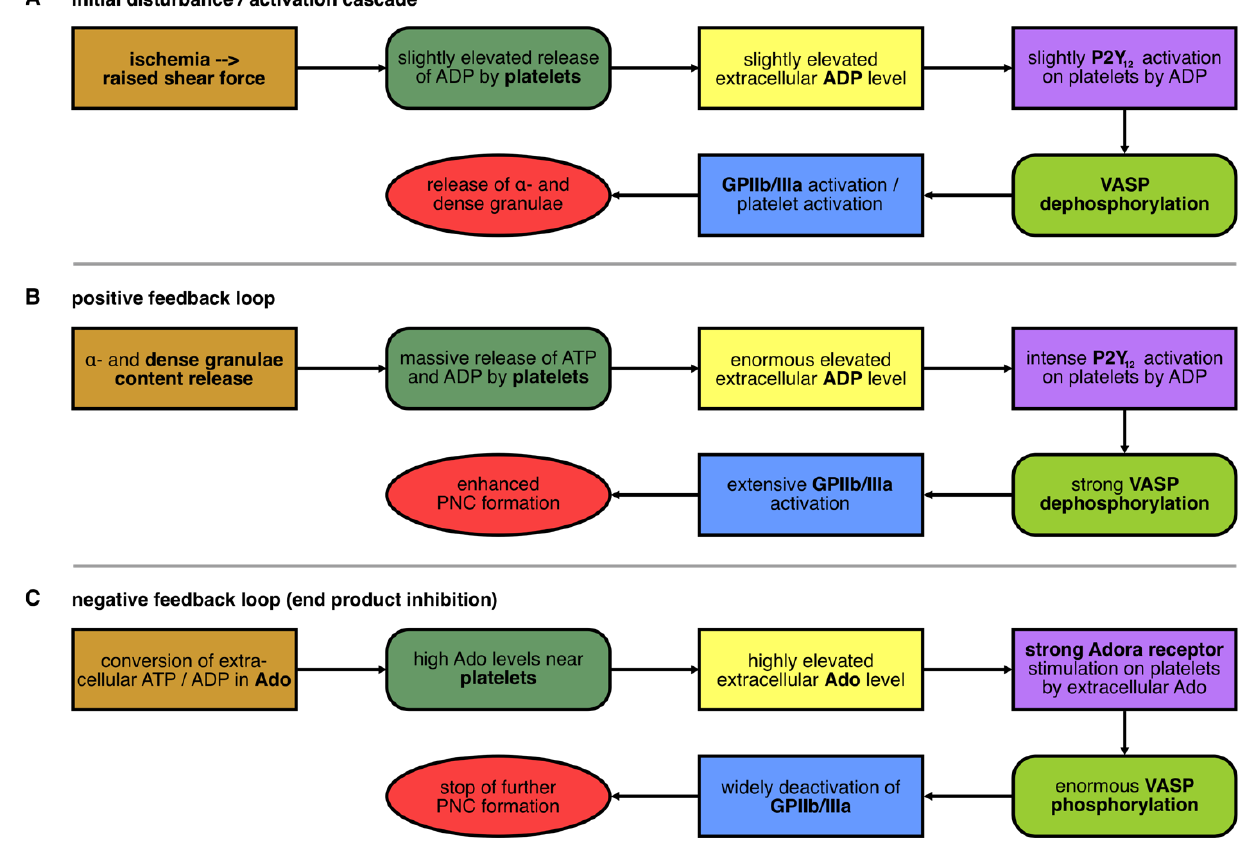
Figure 3. Theoretical description of initial disturbance and feedback loops. Different events are considered under the aspect of the described cybernetic circle. The different defined components of the cybernetic circle are illustrated in form and color, as in Figure 1, and describe the following three physiological processes. ( A ) Initial disturbance by ischemia induces shear force and subsequently results in release of α - and dense granule. ( B ) This starts the positive feedback mechanism. ( C ) The metabolite adenosine (Ado; end product of nucleotide metabolism) is initiating the negative feedback loop.